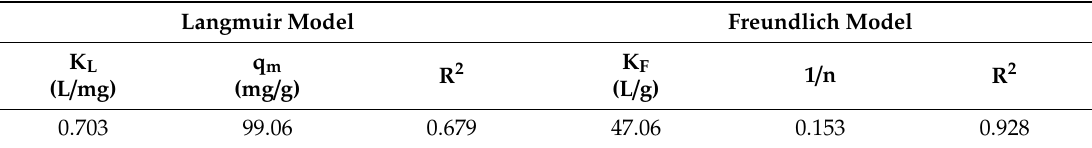
Table 2. Parameters of Langmuir and Freundlich models for adsorption of Cu(II) on surface-modified PAN fibers. Here, K L , K F , q m , n, and R 2 denote the Langmuir and Freundlich equilibrium adsorption constants, maximum sorption capacity of metal ions on adsorbent, Freundlich constant, and determination coe ffi cient, respectively.